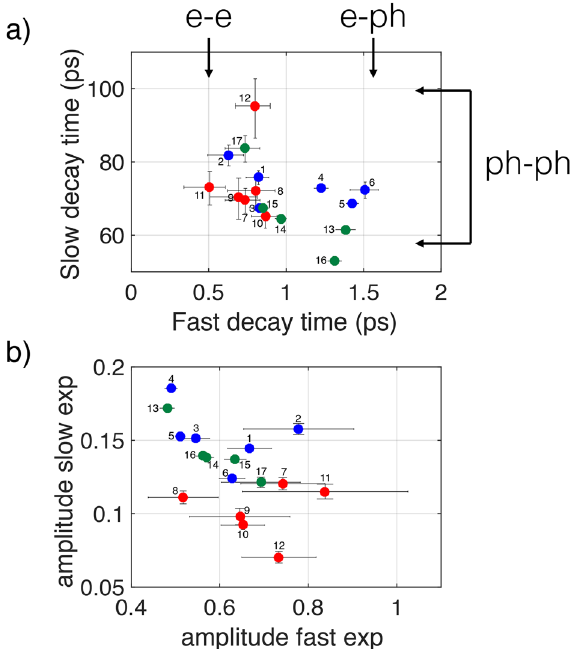
Figure 3. Fitting parameters for the double exponential fit to the data of the selected spectra shown in Fig. 2e. In ( a ) the fast exponential decay times versus the slow exponential decay times are reported. Note that the fast decay times are longer than the electron–electron scattering times (e–e) and slower than the maximum electron–phonon scattering time (e–ph) reported in the literature 3,53,54 . The slow decay time values fall between the limits reported in the literature for phonon–phonon scattering times (ph–ph). In ( b ) the amplitudes of the fast decaying exponentials versus the amplitudes of the slow decaying exponentials are